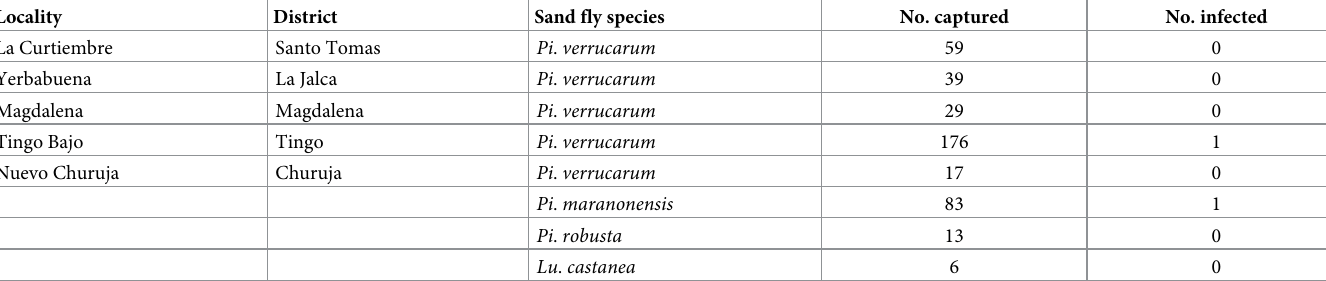
Table 1. Identification of sand fly species and detection of flagellates within sand flies by microscopic examination. Locality